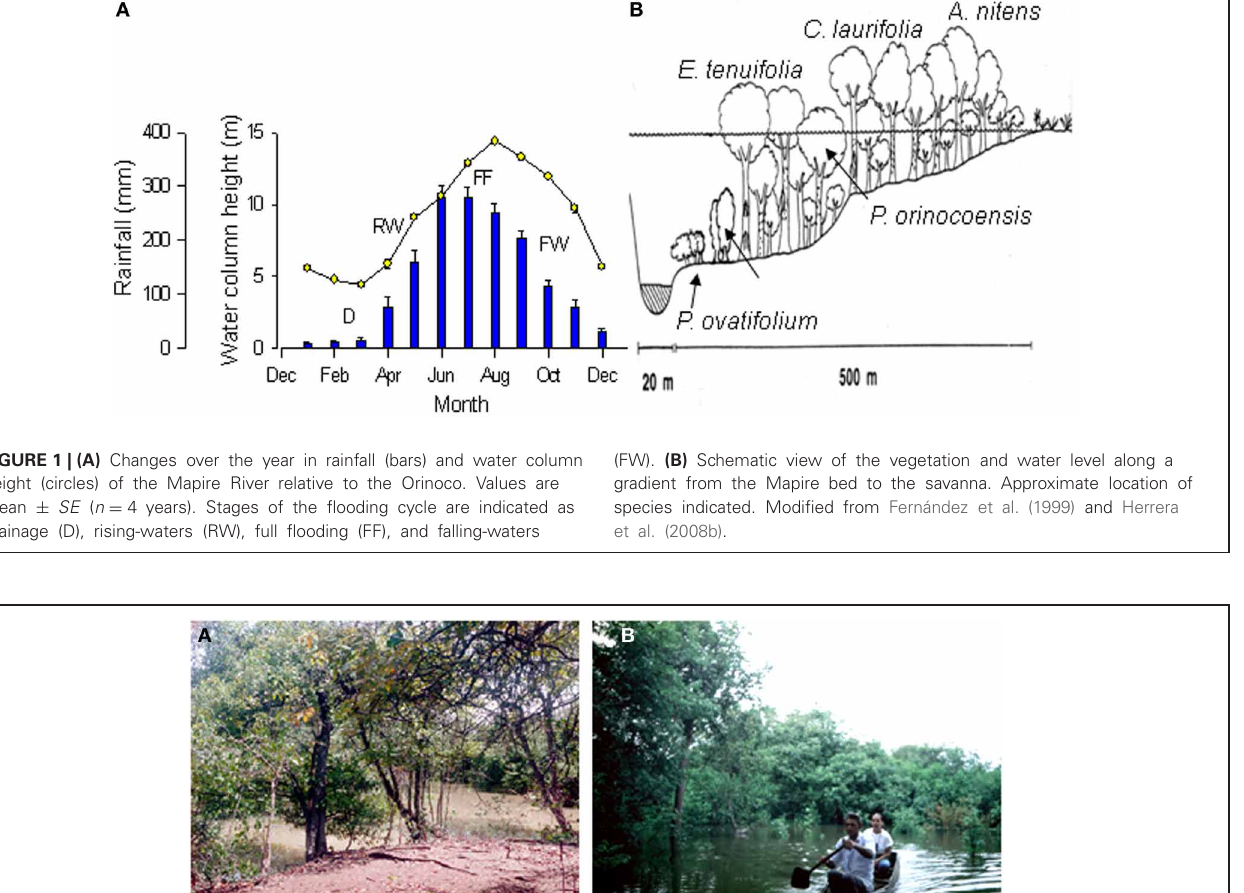
FIGURE 2 | The Mapire igapó forest during (A) drainage and (B) under full